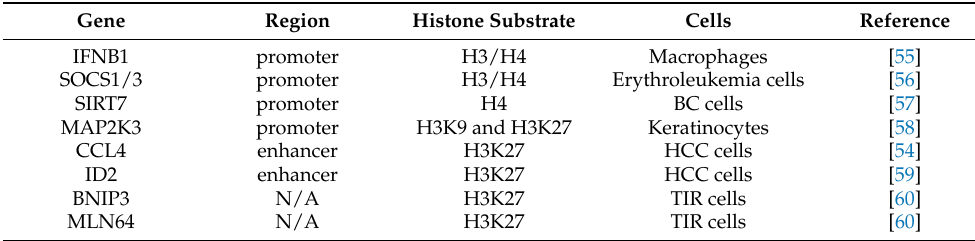
Table 1. HDAC8-mediated transcription repression of target